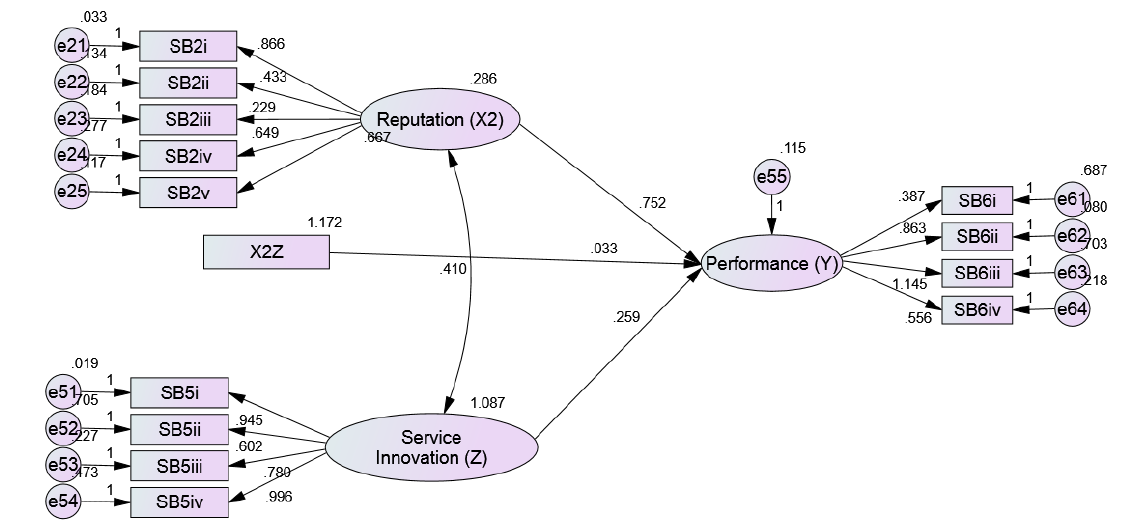
Figure 3: Structural Equation